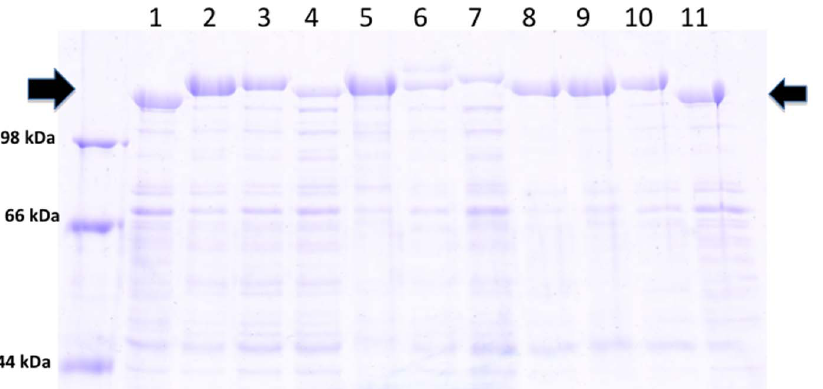
Figure 1. Recombinant S-Layer protein gel. Commassie blue stained 7.5% SDS-PAGE of normalized, low pH extracted protein from C. crescentus strain JS 4038 containing RsaA plasmids. Arrows indicate the location of the S-layer protein. 1) Cc-Control (no insert); 2) Cc-MIP1 a ; 3) Cc-CD4; 4) Cc-